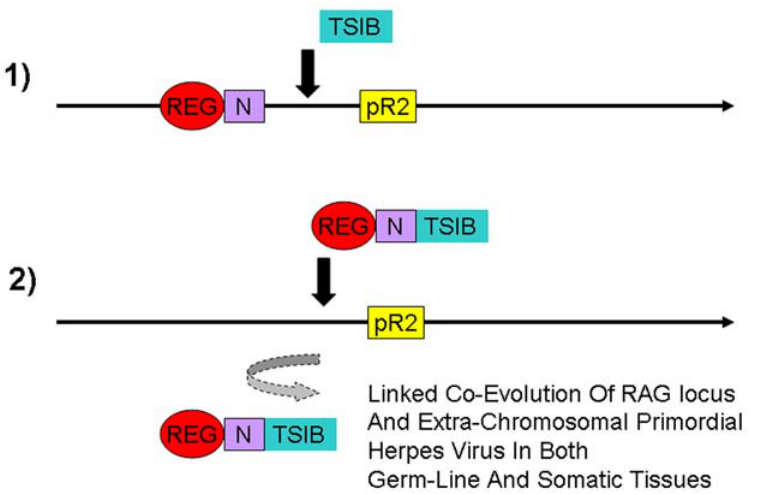
Figure 10. Possible scenarios for origins of V(D)J recombination in the absence of a ‘‘RAG Transposon.’’ The co-regulatory hypothesis presented in this work cannot exclude the possibility that a transib transposon-like element inserted directly into the current RAG locus adjacent to a primordial RAG-2 gene and a conveniently located independent N terminal-like protein with sequences somatically regulated in immune cells already present at the site as shown in the top scenario (Scenario 1). However, this scenario would require several independent coincidences of adjacent N protein and regulatory sequences adjacent to proto RAG2 not found experimentally. Scenario 1 also provides no explanation for the continued presence of the RAG-1/RAG-2-like locus in the modern sea urchin genome in the absence of any known function or slective advantage. In a more probable scenario shown in the bottom panel a herpes-like episome already containing N terminal protein sequences and cis-linked somatic regulatory sequences inserted adjacent to a primordial RAG-2 protein to generate the current RAG site (Scenario 2). After the initial generation of the RAG site in either scenario, the initial selective benefit of the RAG locus may have been to provide immunity to subsequent herpes virus infection rather than V(D)J recombination for an undetermined interval of time during which herpes and RAG protein primary sequences diverged, and this locus may still provide some partial immunity until the present time to conserved ‘‘high-information content’’ regions of the herpes recombinase that cannot diverge due to functional constraints . After the primordial herpes virus lineage had diverged sufficiently in primary sequence to permit re- infection of the primordial deuterostome host with herpes-like pathogens, resumption of the herpes-host arms race would continue until the